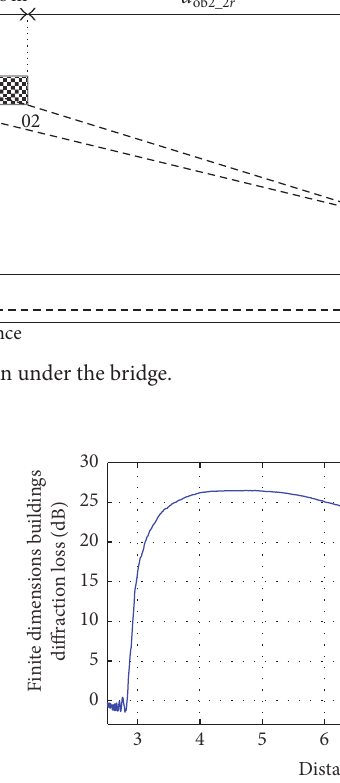
Figure 12: Diffraction loss caused by bridge in measurement 1.